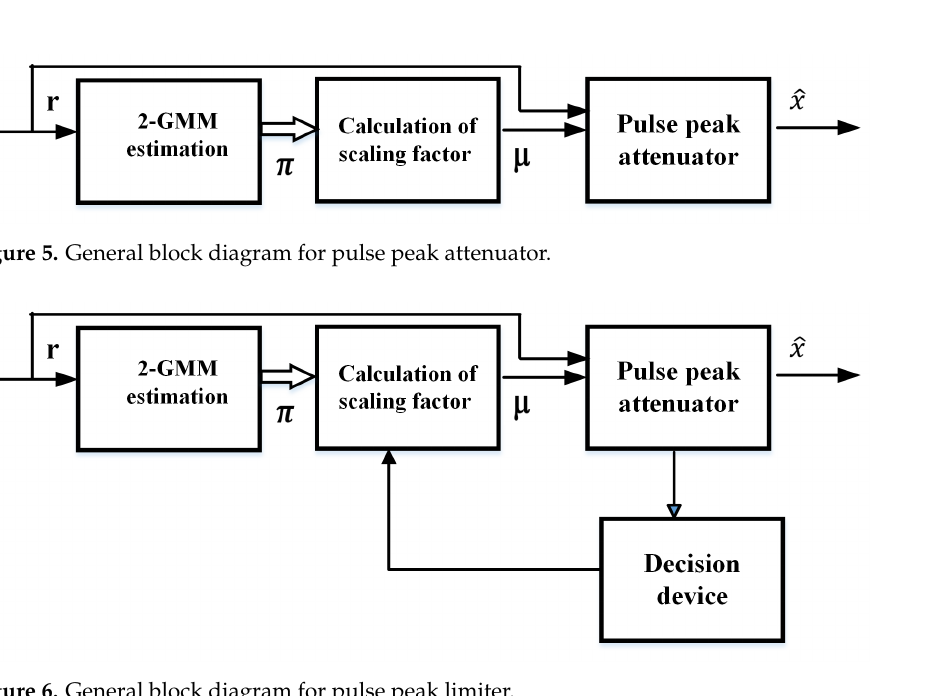
Figure 6. General block diagram for pulse peak